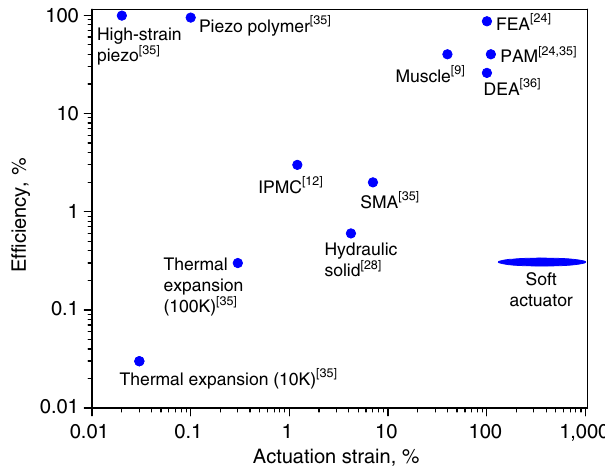
Fig. 6 Maximal ef fi ciency plotted versus actuation strain for various actuating methods. Our material is labeled as “ Soft Actuator ” . For Thermal Expansion actuators, 10 and 100 K are the temperature change ranges in Kelvin degrees. The elliptical shape denotes the range of strain possible ranging from purely linear expansion (140%) to full